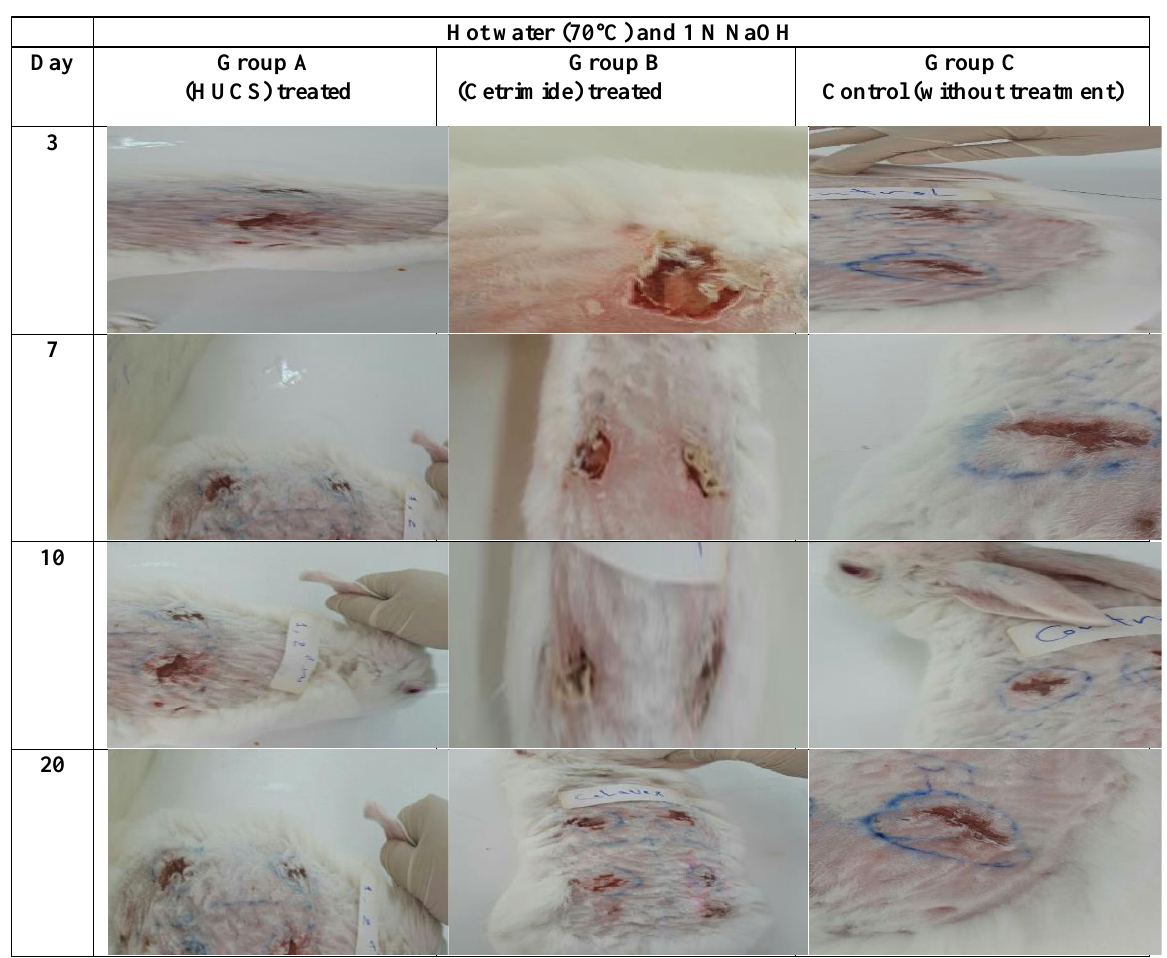
Figure 4. The difference in healing process between rabbit group subjected to both hot water (70°) and 1 N NaOH burns treated with HUCS in comparison with those treated with 0.5% cream and control without